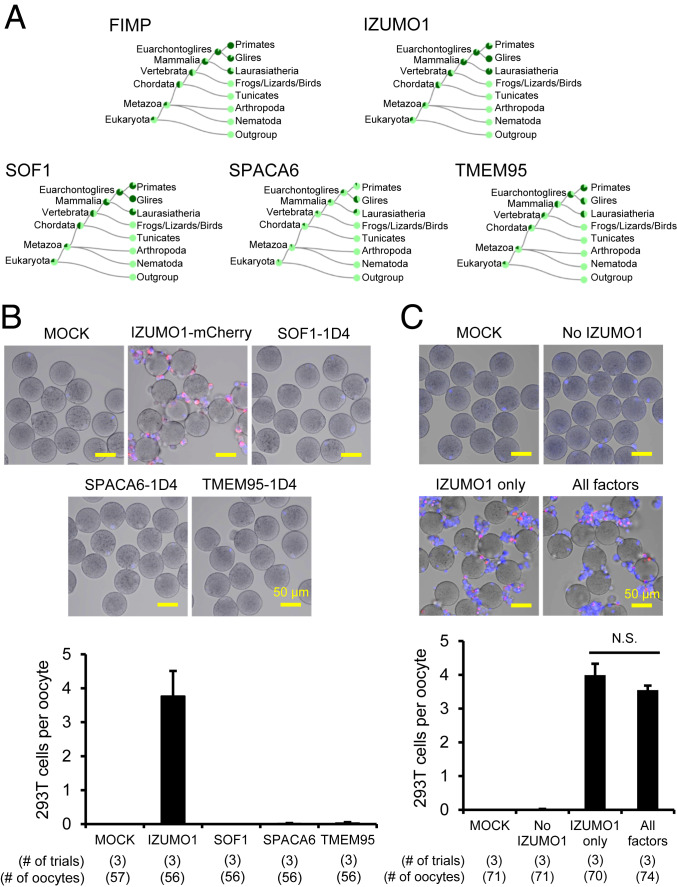
Phylogenetic analyses of the fusion-related sperm proteins and binding assays between ZP-free oocytes and HEK293T cells overexpressing the fusion proteins. (A) Phylogenetic trees of FIMP, IZUMO1, SOF1, SPACA6, and TMEM95 using TreeFam. The presence of orthologs is indicated by dark green. Light green indicates loss of an ortholog in several species within a taxon. (B) Comparison of oocyte binding ability of HEK293T cells individually expressing recombinant IZUMO1, SOF1, SPACA6, and TMEM95. ZP-free oocytes were incubated with Hoechst 33342-preloaded HEK293T cells overexpressing different fusion-related sperm proteins. Only HEK293T cells expressing IZUMO1-mCherry could adhere to the ZP-free oocytes. (C) Comparison of oocyte binding ability of HEK293T cells simultaneously overexpressing various fusion-related sperm factors. HEK293T cells expressing all factors except for IZUMO1 (shown as No IZUMO1) cannot bind to the oocyte surface. No significant (N.S.) difference was observed between the binding indexes of the cells overexpressing all of the five factors and IZUMO1 only.